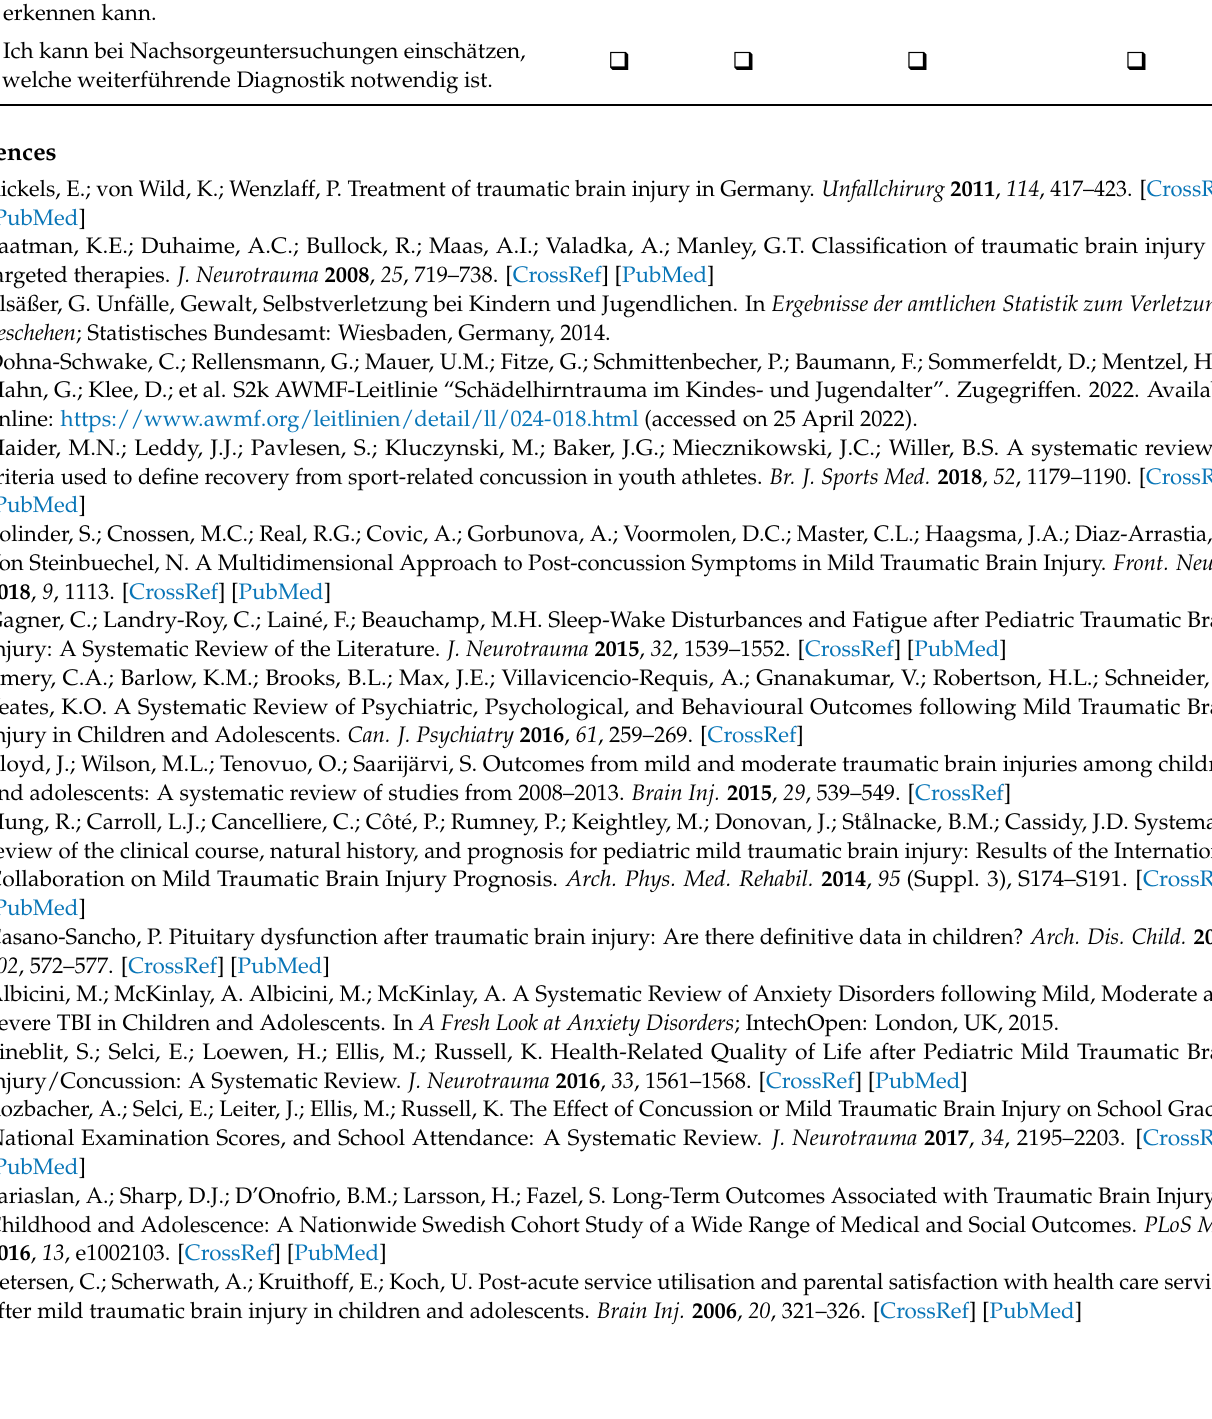
Ich bin der Meinung, dass ich mögliche Spätfolgen (Spätfolgen wird hier definiert als: anhaltende Symptomatik 6 Monate nach dem Ereignis) eines SHT erkennen